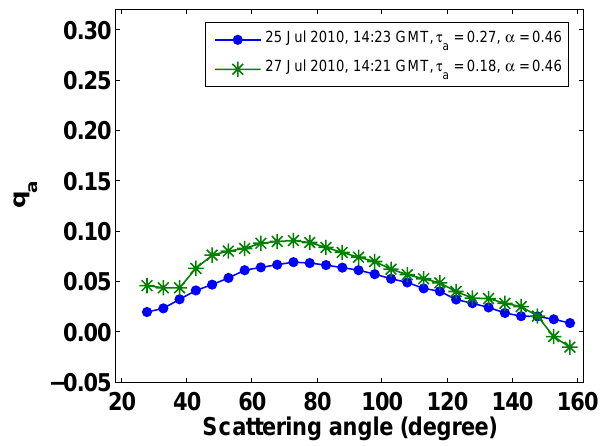
Fig. 8. Correlation between q a ( max ) and ω 0 at 870nm. Colors are mapped to different values of τ a . The diameter of each data point corresponds to α − 1 .